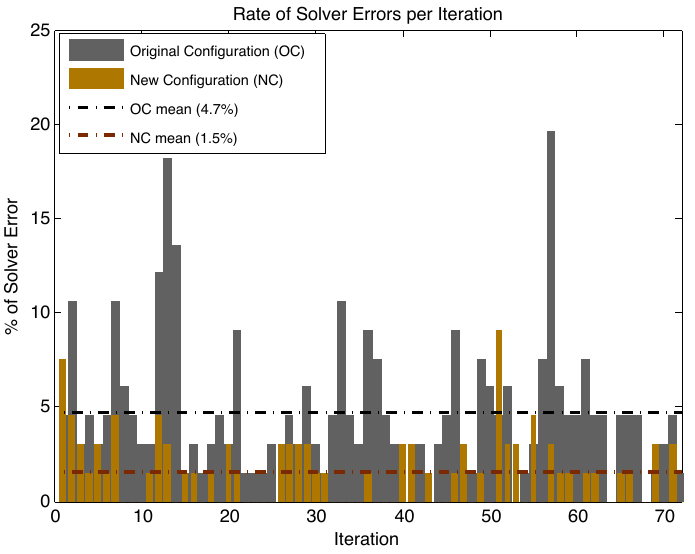
Figure 4. Rate of Solver Errors for the ENNC.